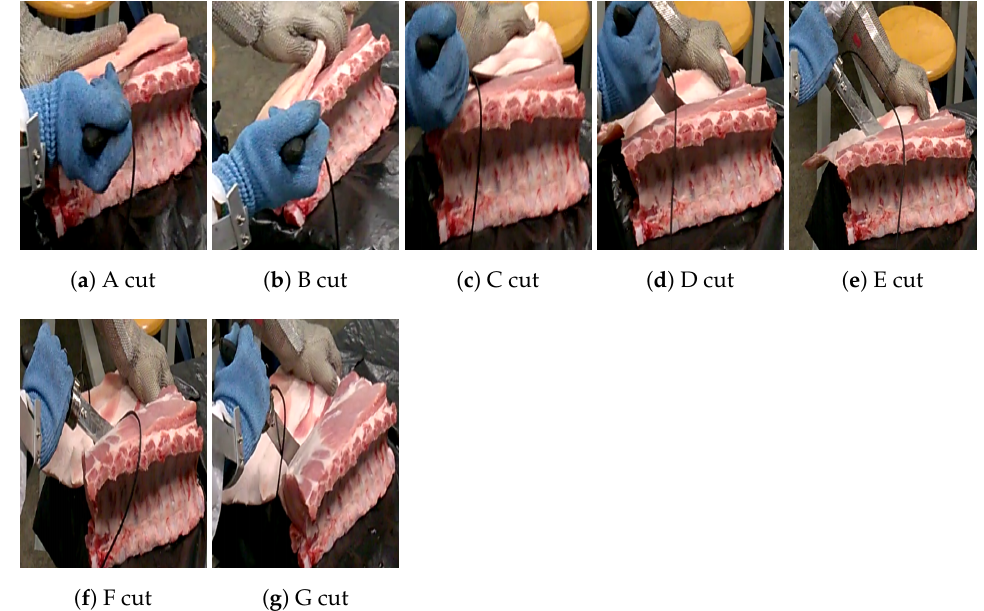
Figure 27. Experiment 6—manual pork cutting.